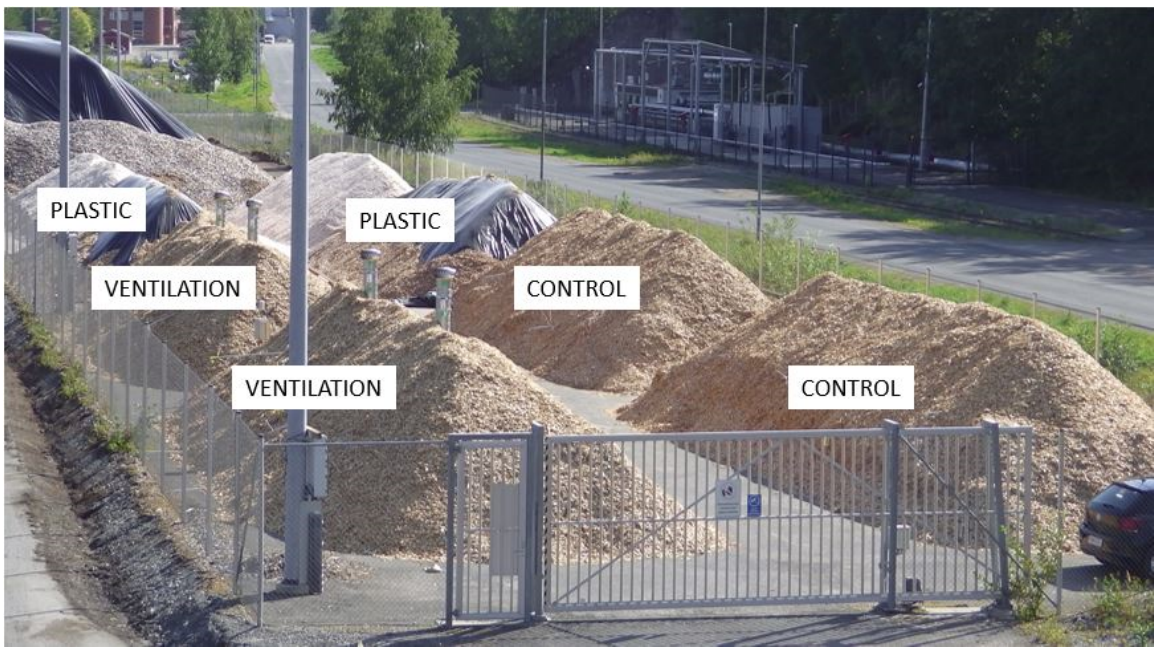
Figure 1. Location of the experimental piles included in the present study by storage treatment.